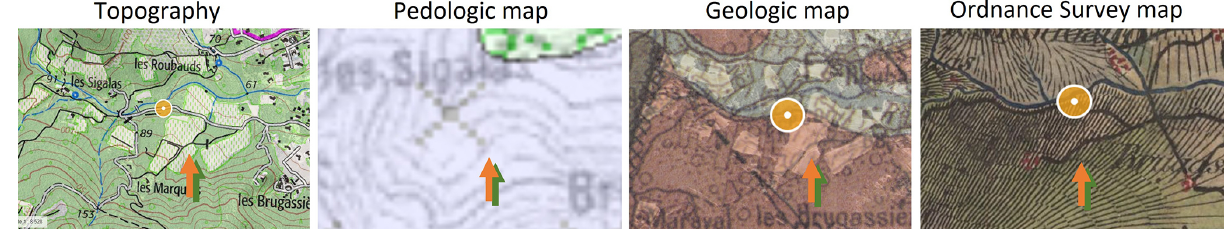
Figure A2. Topographic, pedologic (source: soil reference system of the VAR), geologic, and ordnance survey map, 1820–1866 (source: https://www.geoportail.gouv.fr, last access: 8 November 2019). The brown arrow is the crop, and the green arrow is the forest.